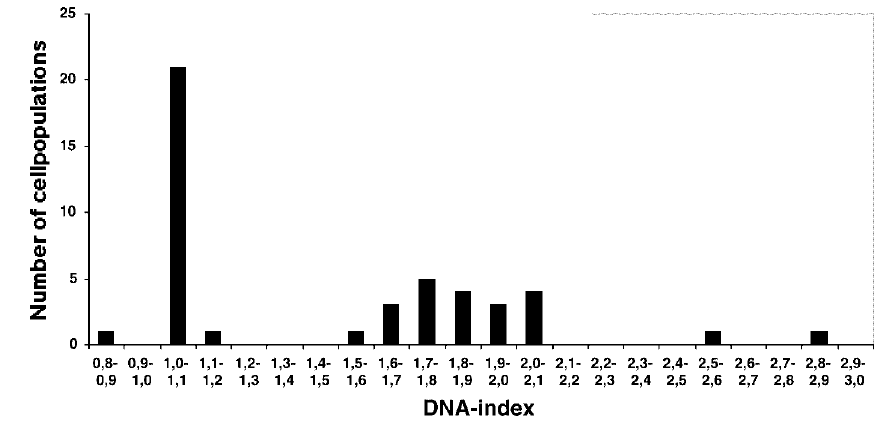
Fig. 2. Distribution of DNA-indices in 45 cellpopulations from 26 patients with gallbladder cancer of early local tumour stage